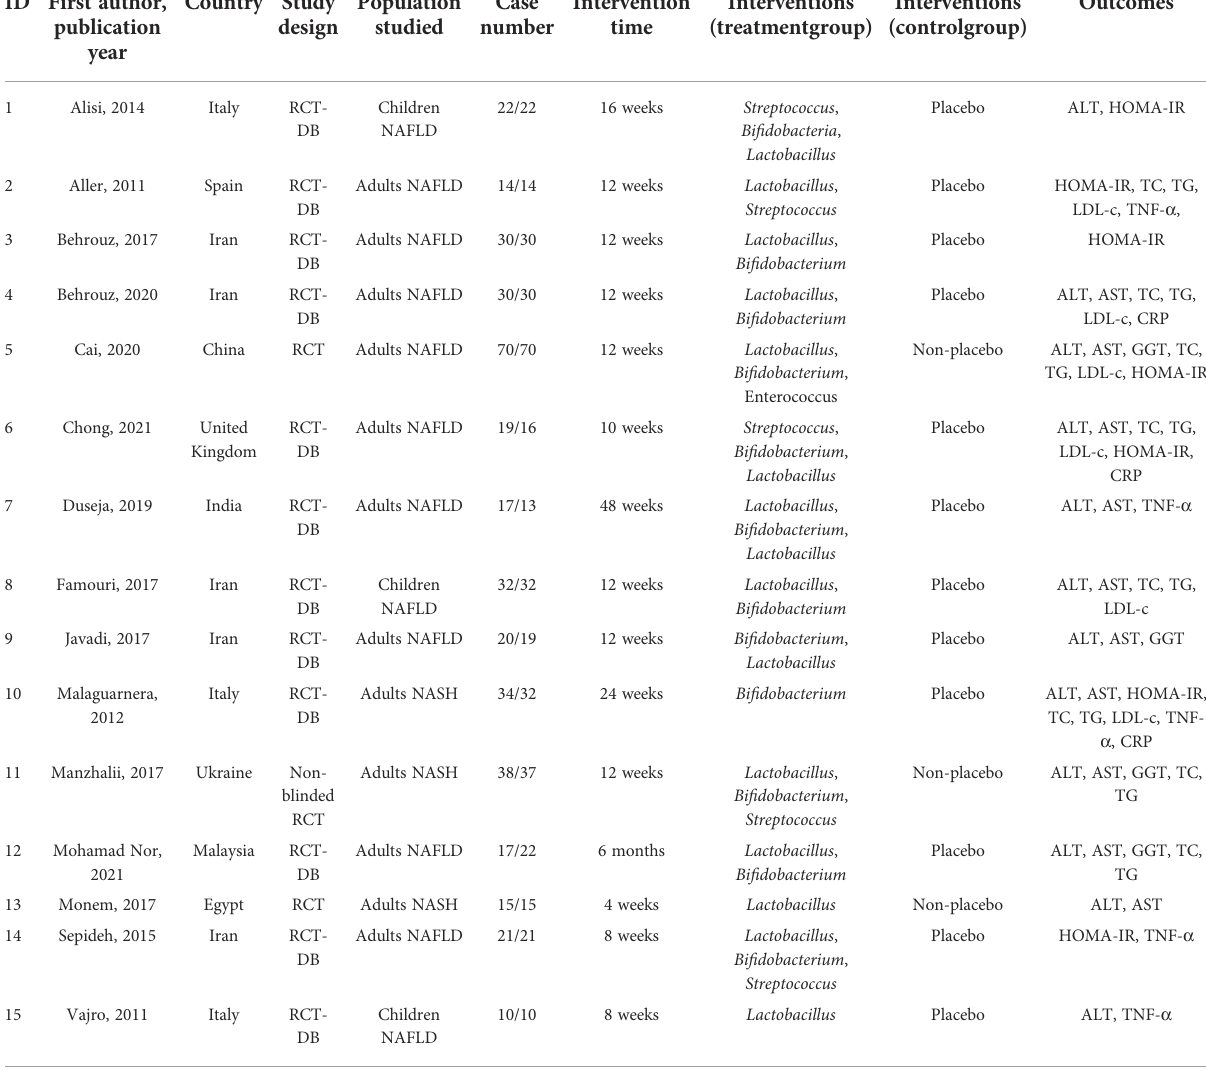
TABLE 1 Characteristics of included randomized controlled